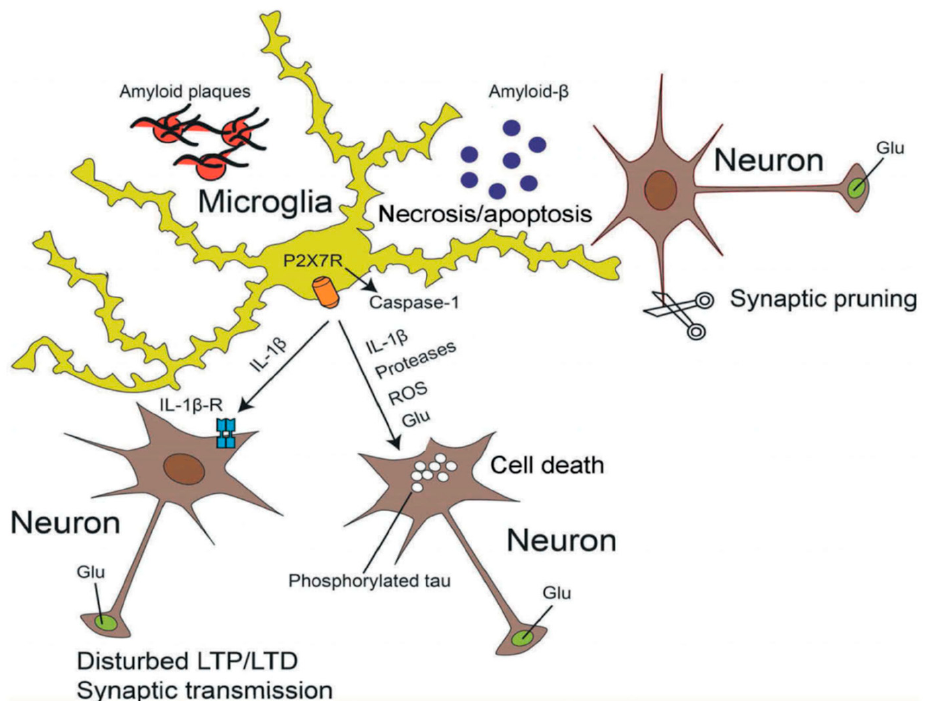
Figure 2. Effects of activated microglia on neighboring neurons. Soluble β -amyloid (A β ) aggregates and thereby forms fibrillary plaques surrounded by microglial cells. Microglia are endowed with P2X7Rs, whose stimulation by high concentrations of ATP causes the activation of